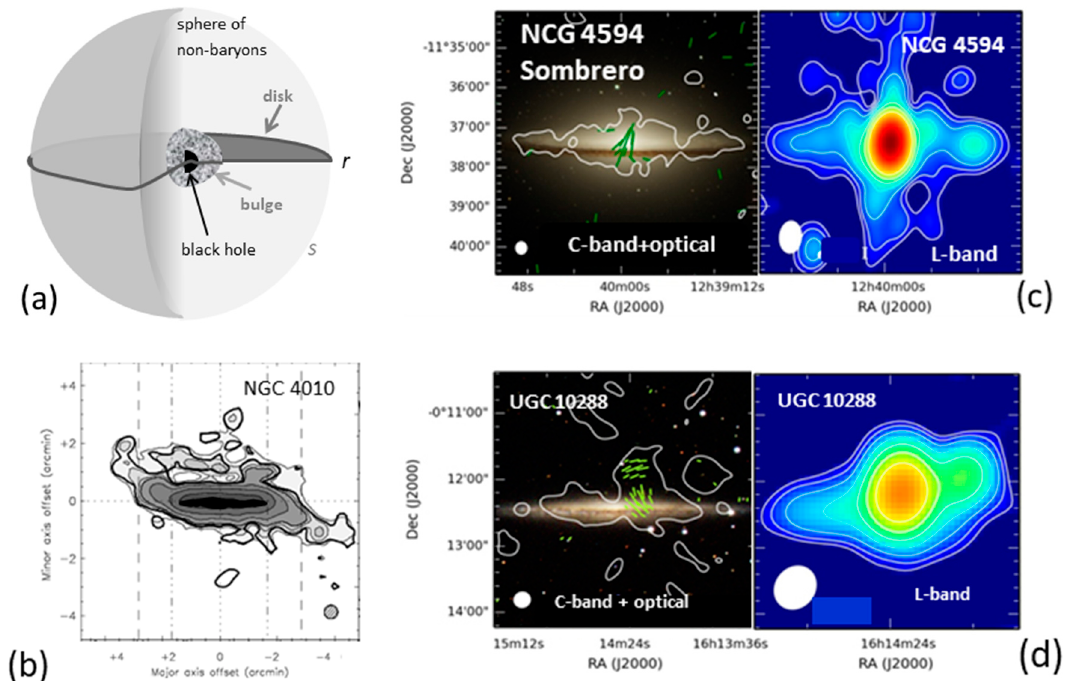
Figure 1. Postulated and measured distributions of baryonic and non-baryonic types of matter in spiral galaxies: ( a ) schematic of a spiral galaxy with a purported halo of non-baryonic dark matter (NBDM), as used in Newtonian Orbit Models (NOMs). Components in this perspective view are labeled. For simplicity, the disk represents stars along with detectable H atoms. Other figure parts show cross sections; ( b ) contours of H atoms surrounding an edge-on spiral galaxy (NGC 4010, also known as UCC 6964) detected using a 21-cm line. The black lens shape shows the extent of the visibly detected galaxy. Panel (b) is modified after Figure 13 (panel 11) of Reference [13], with permission. This distribution of H atoms is analogous to an atmosphere around a star or planet; ( c ) and ( d ) radio contours of two additional edge-on galaxies in the C- and L-bands, with superimposed optical images, modified after Wigert et al. [14]. Both panels are publically available from CHANG-ES [15].